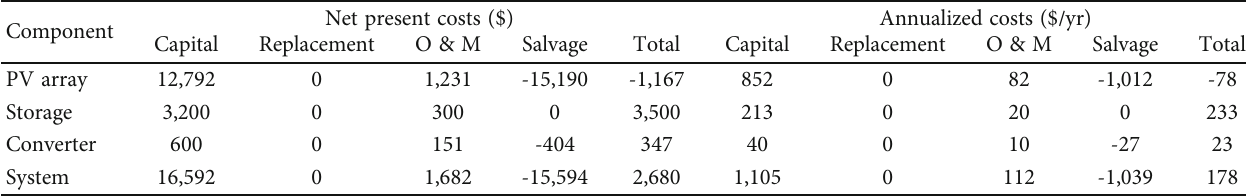
Table 3: Present worth and annualized value of all costs over 10 years.